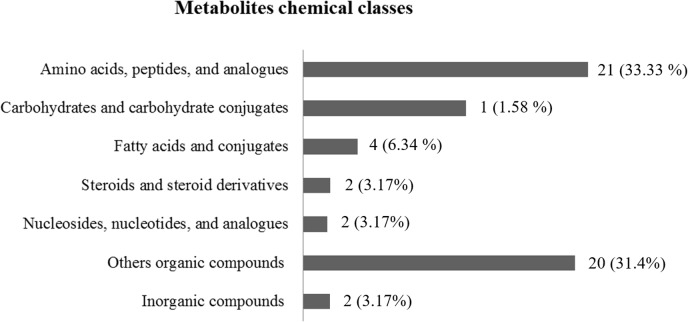
Number of metabolites per chemical class.Metabolites identified were categorized according to their chemical classes, defined as amino acids, peptides and analogues; carbohydrates and carbohydrate conjugates; fatty acids and conjugates; steroids and steroid derivatives; nucleosides, nucleotides, and analogues; others organic compounds and inorganic compounds.